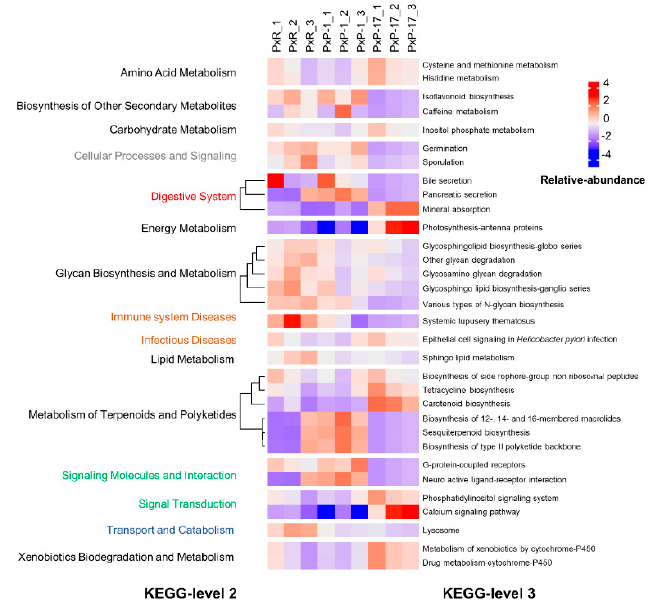
Figure 4. Gut microbiota functional profiles of each P. xylostella population at different Kyoto Encyclopedia of Genes and Genomes (KEGG) levels. PxR: P. xylostella feeding on radish; PxP-1 and PxP-17: the 1st and 17th generation of P. xylostella , respectively, feeding on peas after host shift from radish. Different colors in KEGG-level 2 represent different functions from those of KEGG-level 1, with black representing metabolism, grey representing unclassified function, red representing organismal systems, blue representing cellular processes, green representing environmental information processing, and orange representing human diseases.